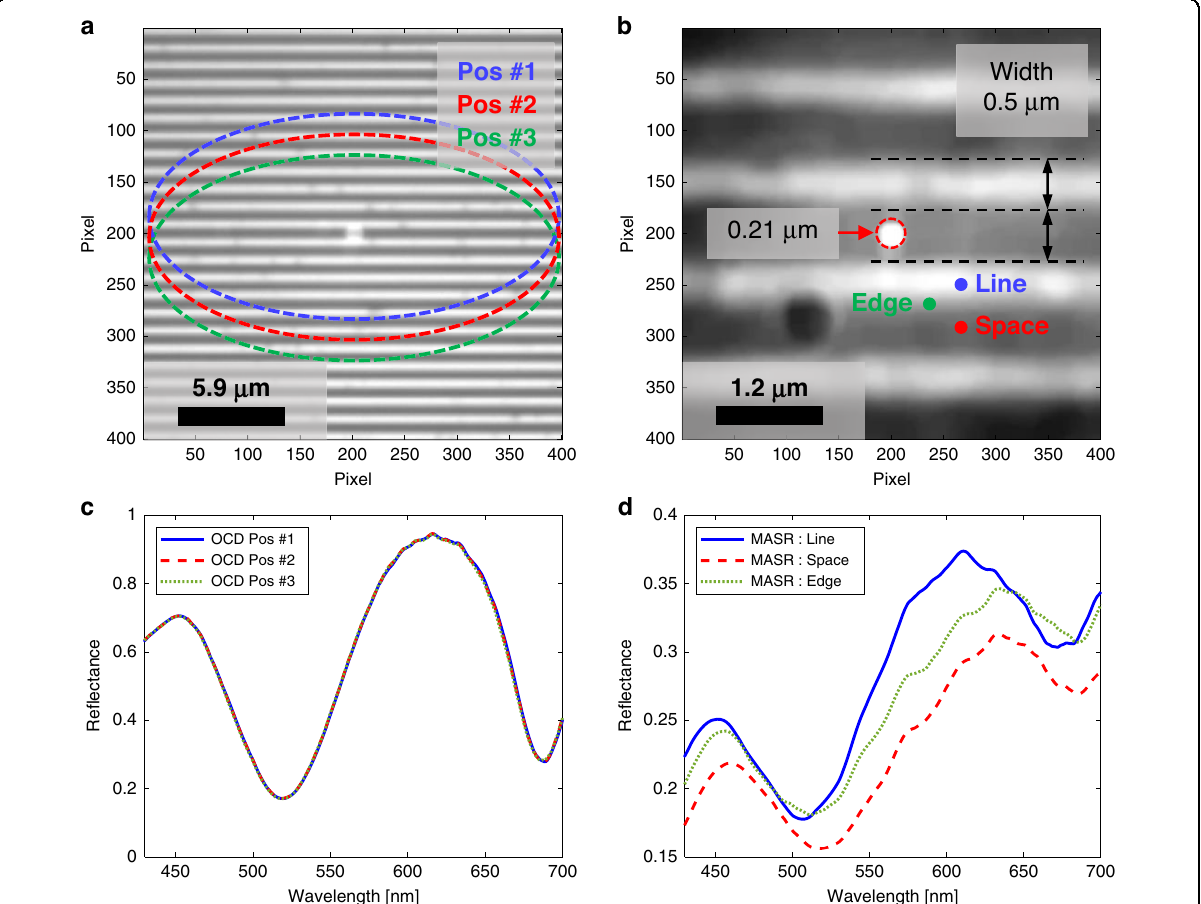
Fig. 7 Spectral measurements for an extremely small spot obtained by the MASR system. 0.5- μ m line width and 1- μ m pitch grating pattern and the re fl ectance measurement areas (schematically superimposed) for a the spectroscopic ellipsometer in the ×100 image, which had a spot of major axis 25 μ m for three different positions, and b the approximately ×530 super-resolution image obtained by the microsphere and relevant positions (line, space, and edge). c Spectral re fl ectance of the ellipsometer for the positions in a . d Spectral re fl ectance of the MASR system for the positions in b . (OCD optical CD, Pos position).